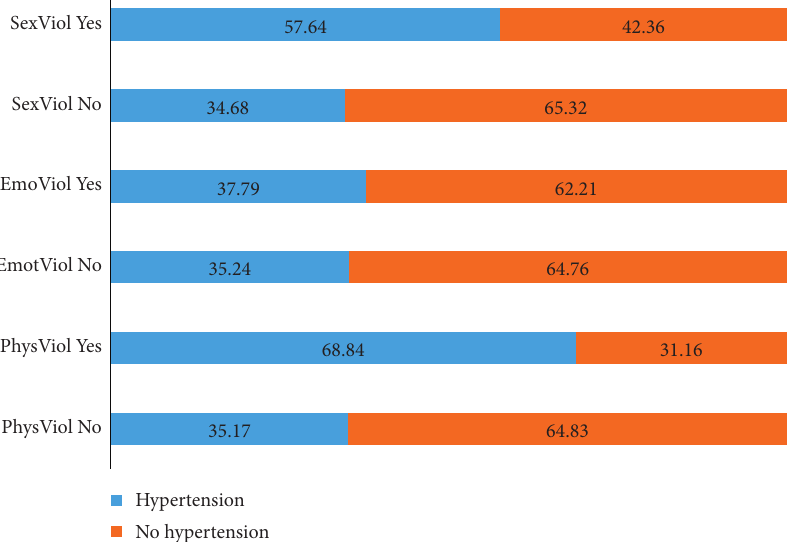
Figure 2: Percentage distribution of hypertension females (15–34 years old) by experiences of intimate partner violence, South Africa,